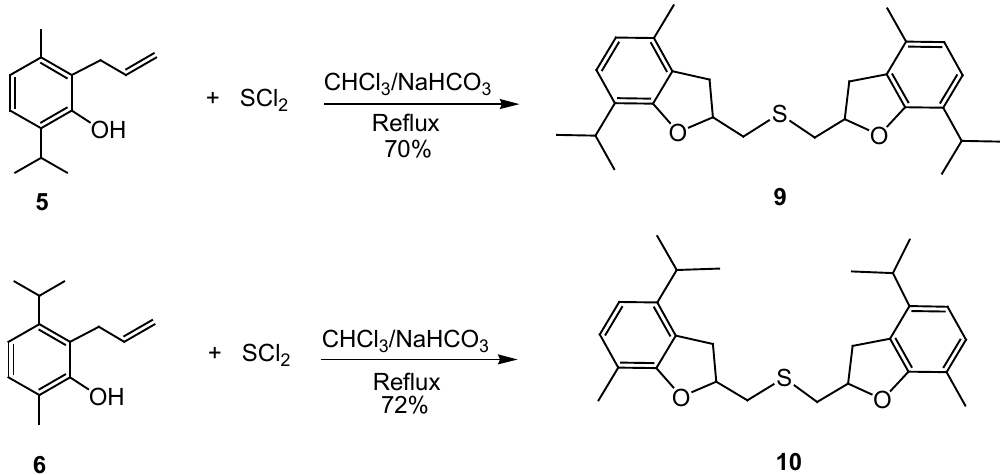
Scheme 4. Synthesis of sulfides 9 and 10 by the reaction of sulfur dichloride with allyl thymol 5 and allyl carvacrol 6 .